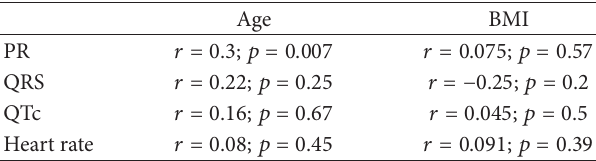
Table 4: Correlation analysis.